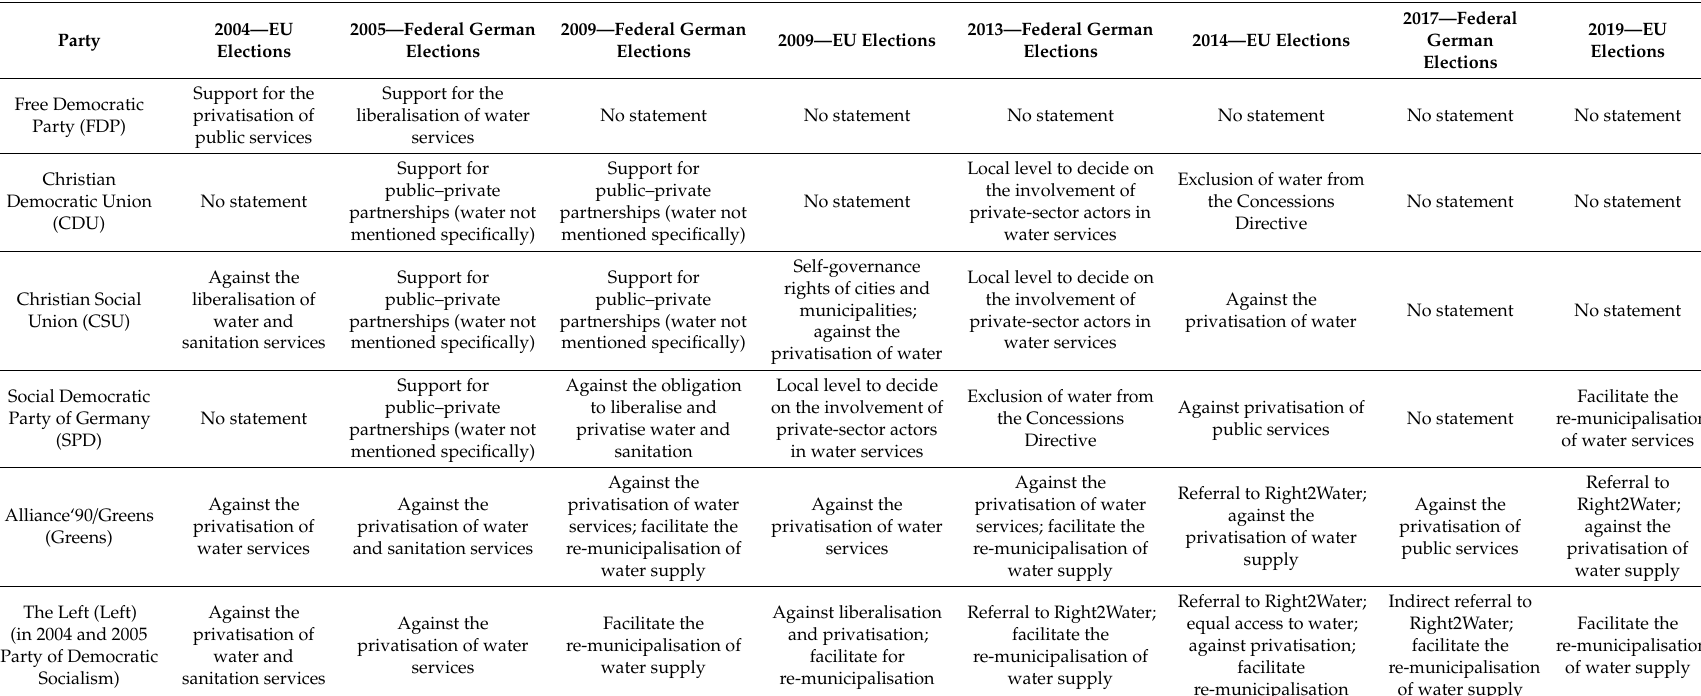
Table 3. Overview of the German parties’ statements,